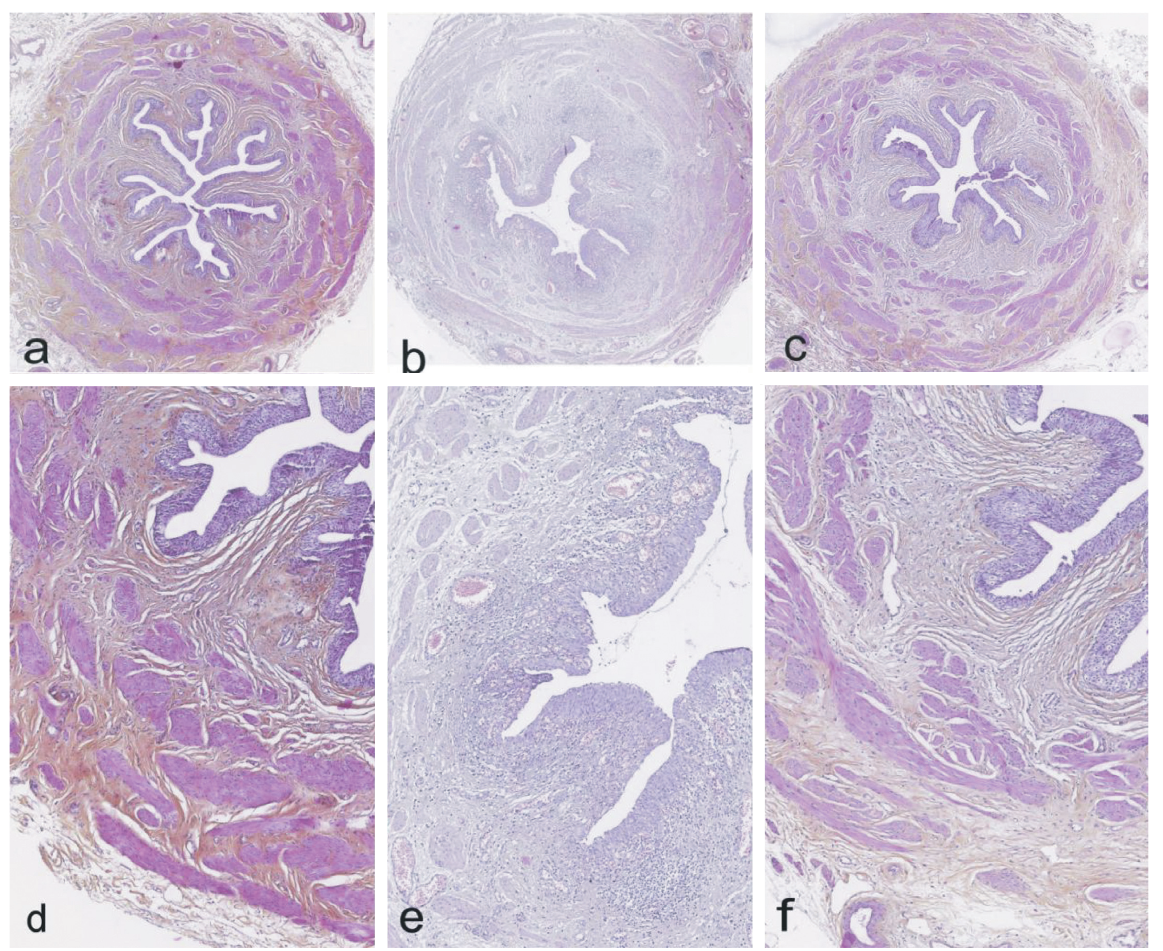
Figure 1: Histological appearance with hematoxylin-eosin staining. (a–c) Original magnification x3. (d–f) Original magnification x7. (a, d) Unstented control ureter showing no inflammation. (b, e) Ureter with the double-pigtail stent showing a marked ureteral inflammatory reaction. (c, f) Ureter with 0.3F suture thread showing no